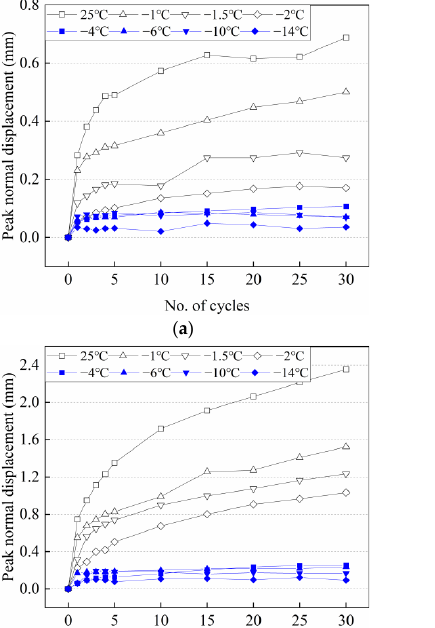
Materials 2022 , 15 , x FOR PEER REVIEW 17 of 27